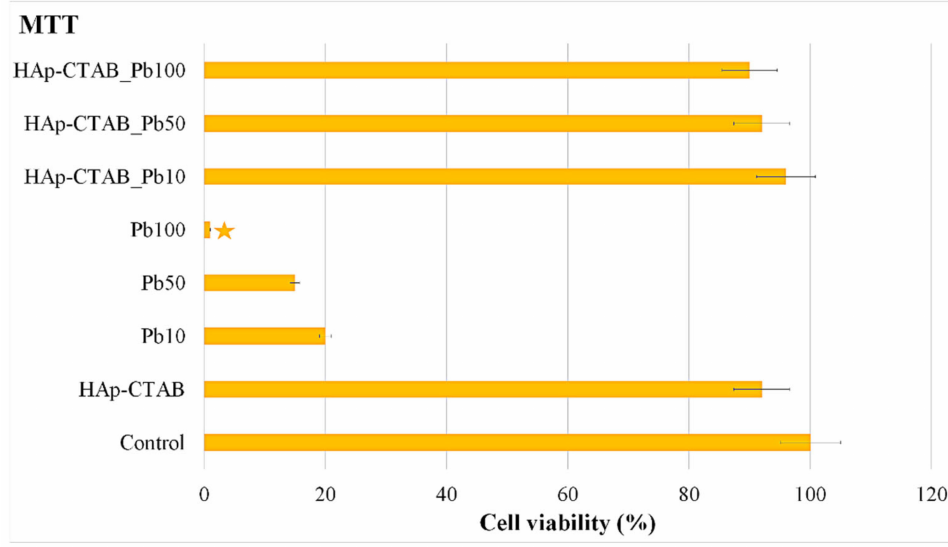
Figure 11. Cell viability of HeLa cells incubated with water in the presence of HAp-CTAB nanocom- posites, Pb 2+ contaminated solutions, and decontaminated solutions using HAp-CTAB nanocompos- ites. HeLa cell culture was used as the